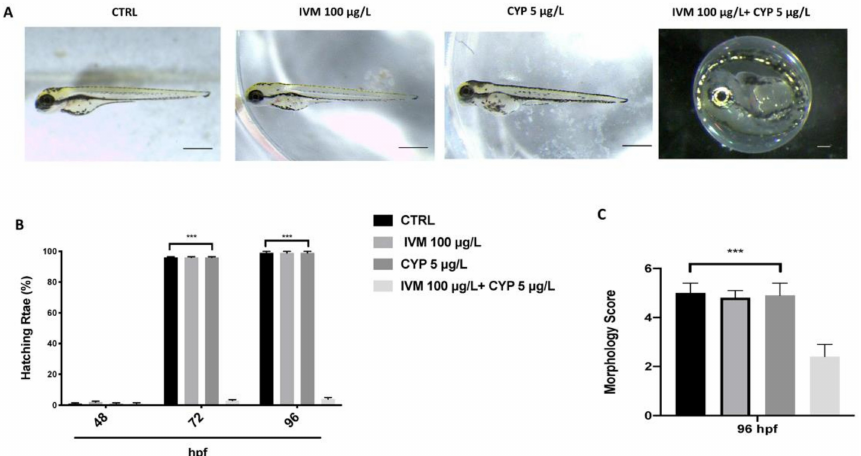
Figure 5. Effects of single and co-exposure of IVM and CYP on morphological changes in zebrafish larvae at 96 hpf ( A ). Hatching rate ( B ) and morphological scoring ( C ). Values = means ± SD of three independent experimental datapoints: *** at p < 0.001 against